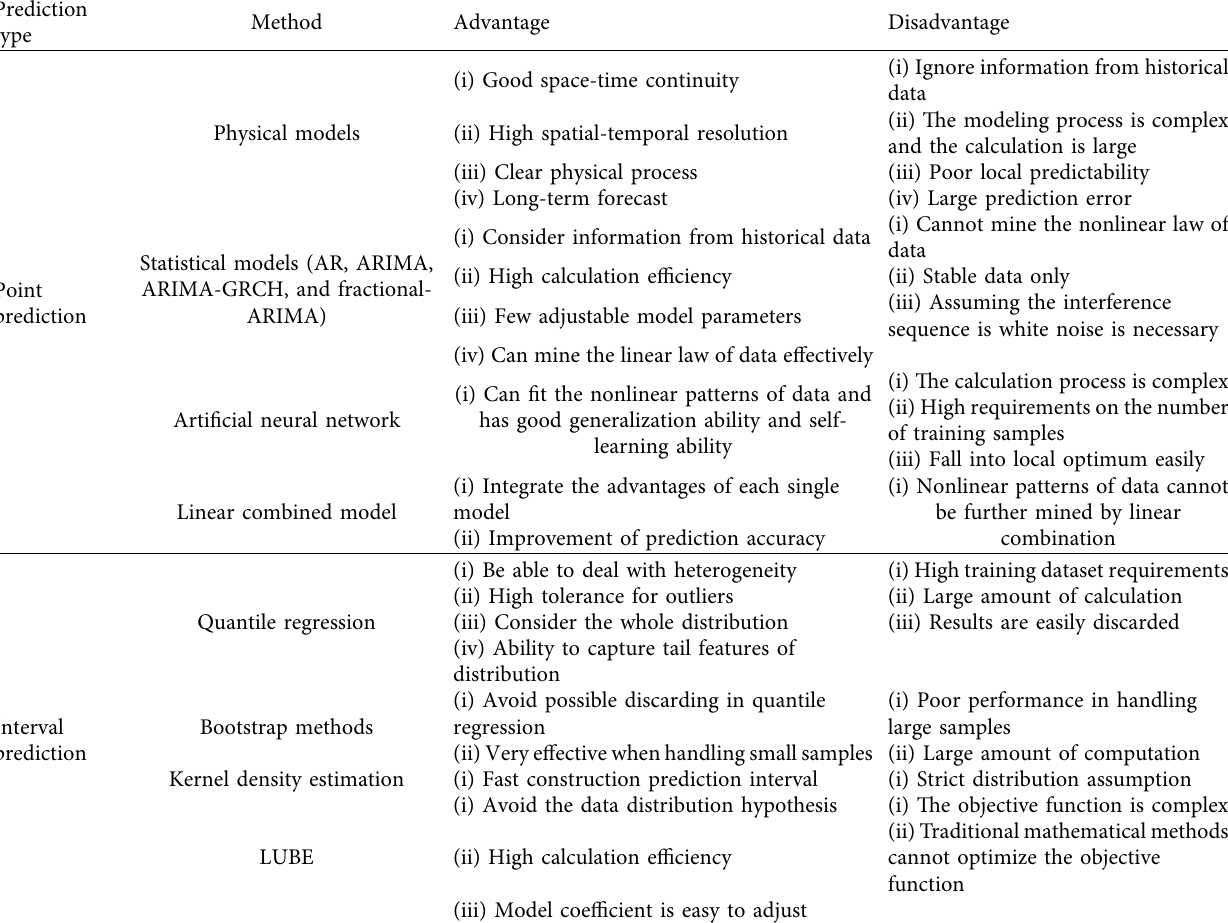
Table 1: Evaluation summary of point prediction and interval prediction